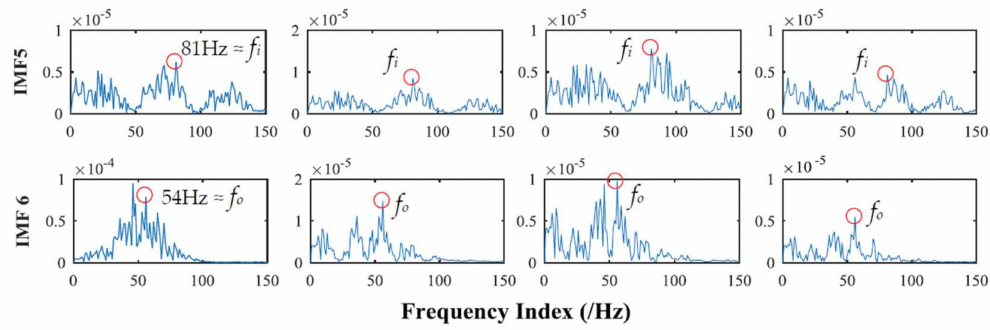
Figure 20. Frequency domain plots of effective IMFs of MEMD.